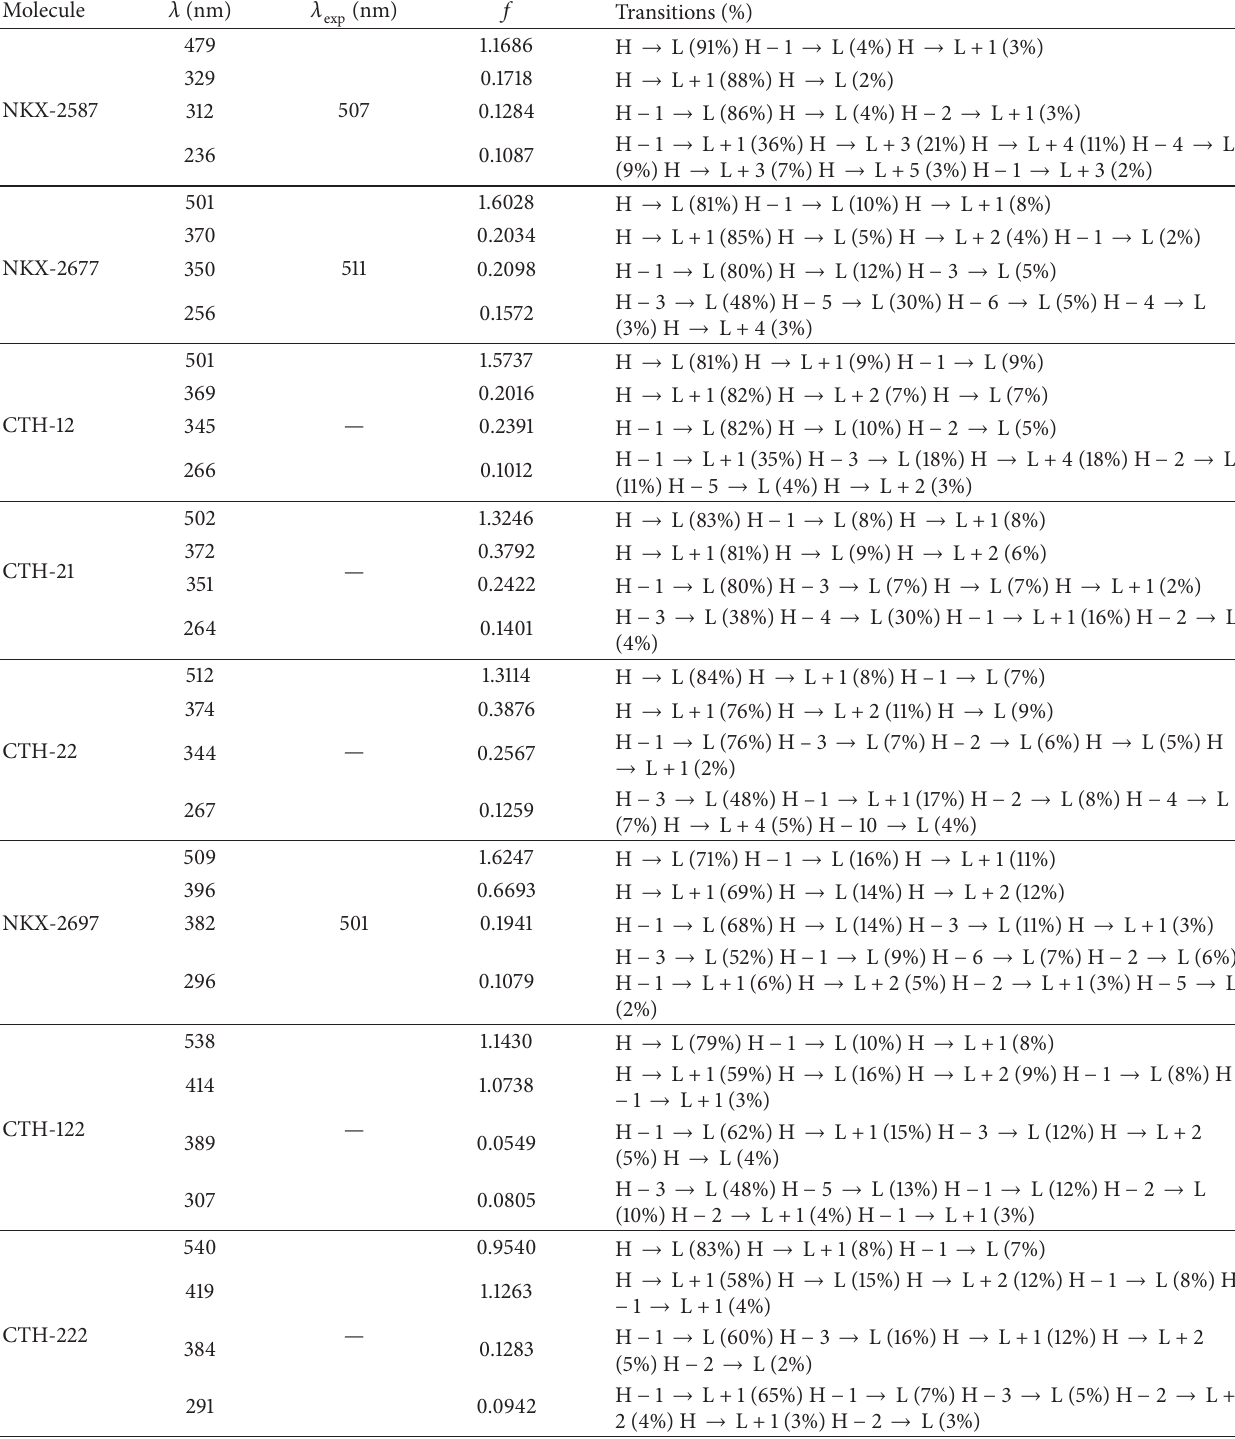
Table 1: Absorption wavelengths, oscillator strengths ( 𝑓 ), and the orbitals involved in the transitions of coumarin derivatives using M06- 2X/6-311G(d) and acetonitrile as